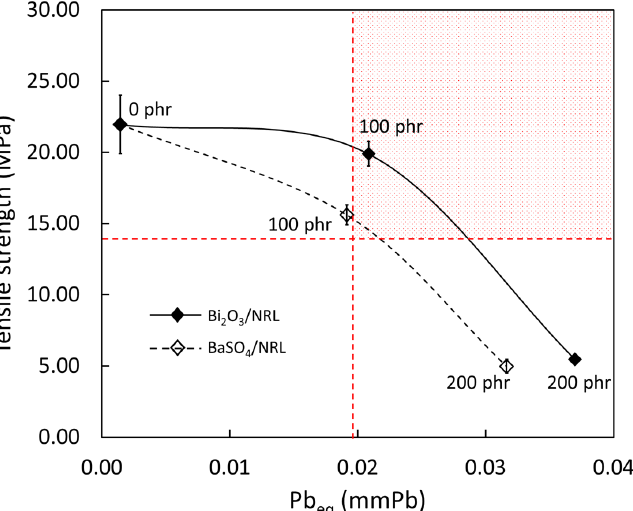
Figure 9. Relationship between tensile strength and Pb eq (from XCOM) of nano-Bi 2 O 3 /SVNRL (solid line) and nano-BaSO 4 /SVNRL (dotted line) composites. The shaded area in the top-right corner indicates the conditions for which samples satisfy both tensile strength and Pb eq requirements for medical X-ray protective gloves (ASTM D3578-19).